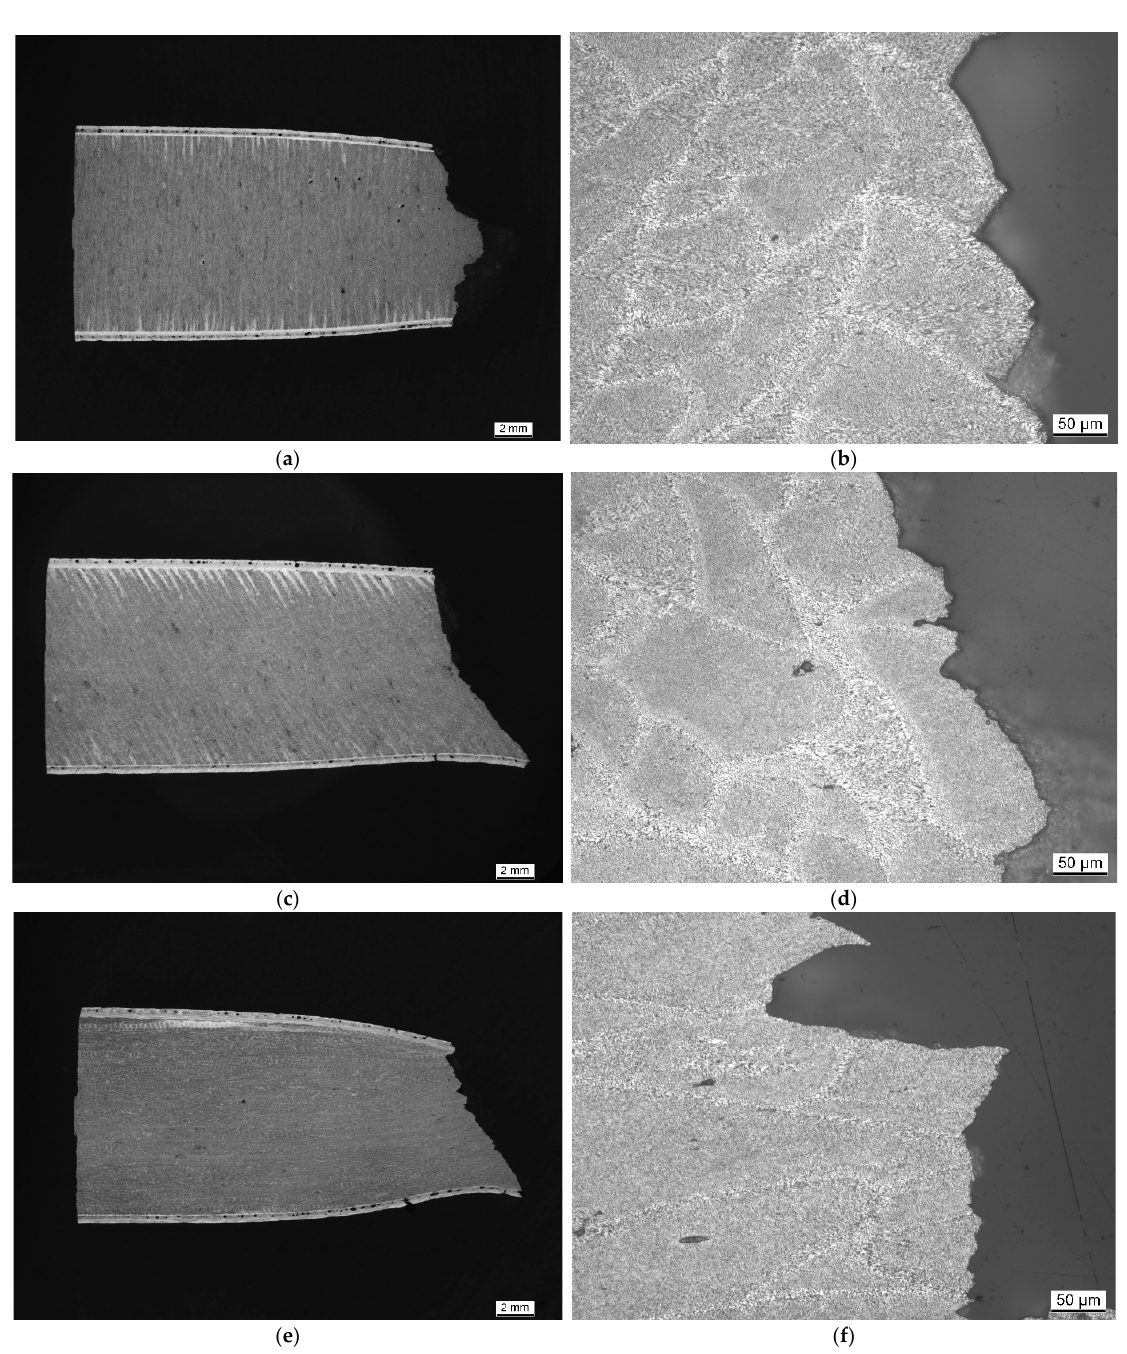
Figure 12. Metallographic sections of etched samples produced at varied polar angles after tensile testing at 250 ◦ C. Left, general overview, right, detailed view of the fracture zone: ( a , b ) polar angle 0 ◦ , ( c , d ) polar angle 45 ◦ and ( e , f ) polar angle 90 ◦